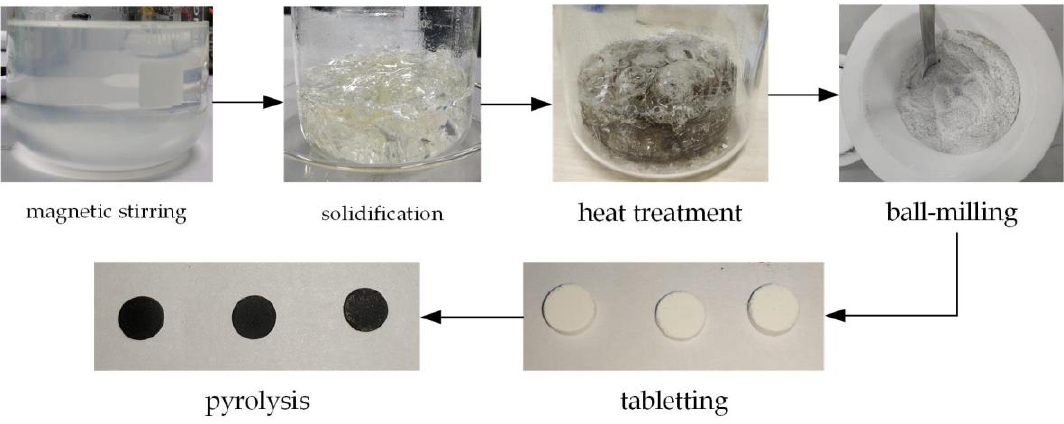
Figure 7. SiAlCO ceramic production process.